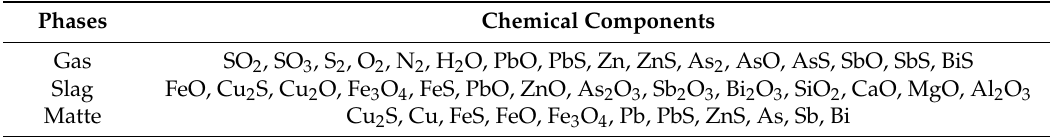
Table 1. Chemical components in SKS copper smelting